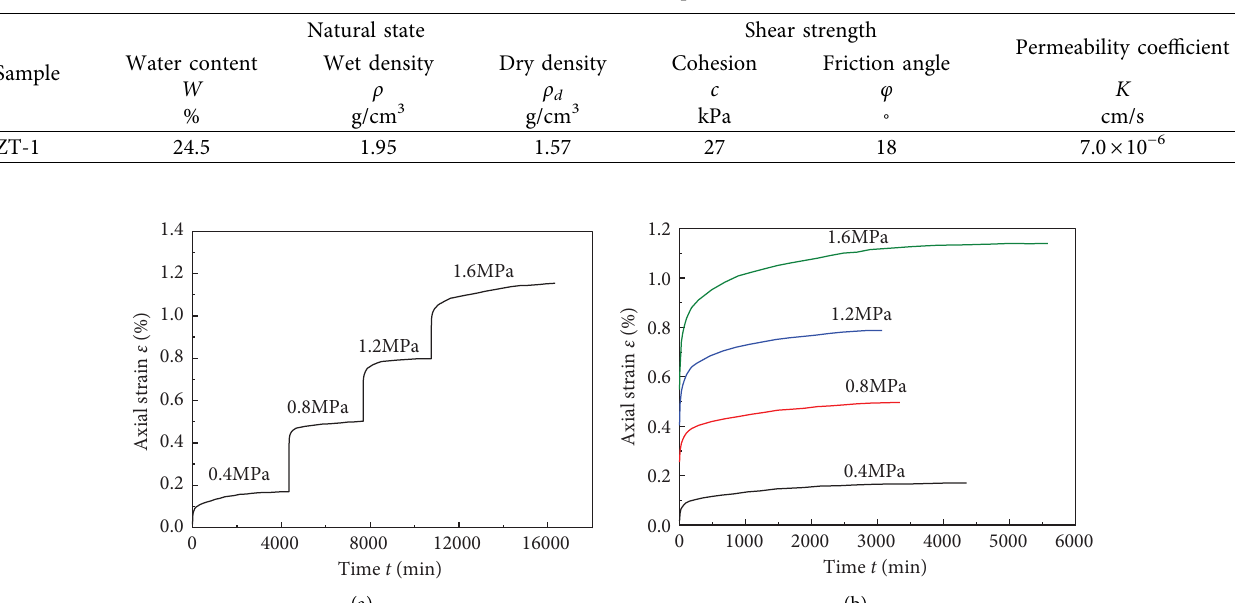
Figure 3: Triaxial rheological mechanical property test. (a) Graded loading rheological curve; (b) axial loading rheological curve.